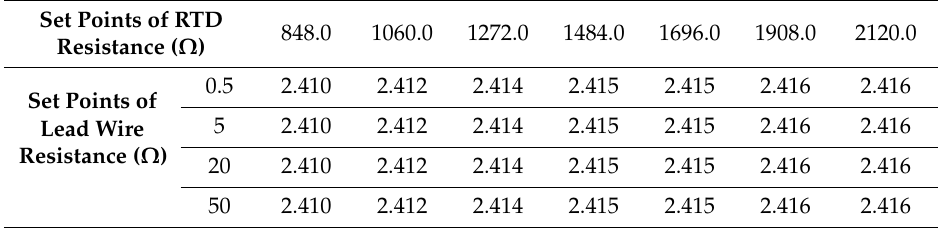
Table 2. Voltage across zener diode by the resistance of the resistance temperature detector (RTD) and lead wire (in